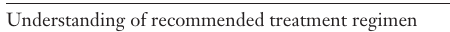
Follow-up assess- ment 4–6 weeks after discharge from hos- pital for an acute ex- acerbation of